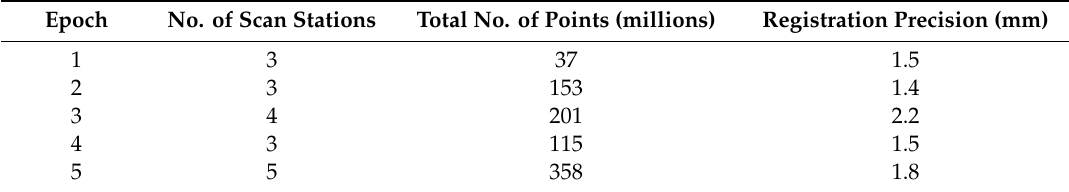
Figure 6. ( a ) Graduate Student Hall of Residence (GSHR) construction site; ( b ) plan view of the portion of the site under study. Table 1. Number of scan stations, number of points, and registration precision per epoch.